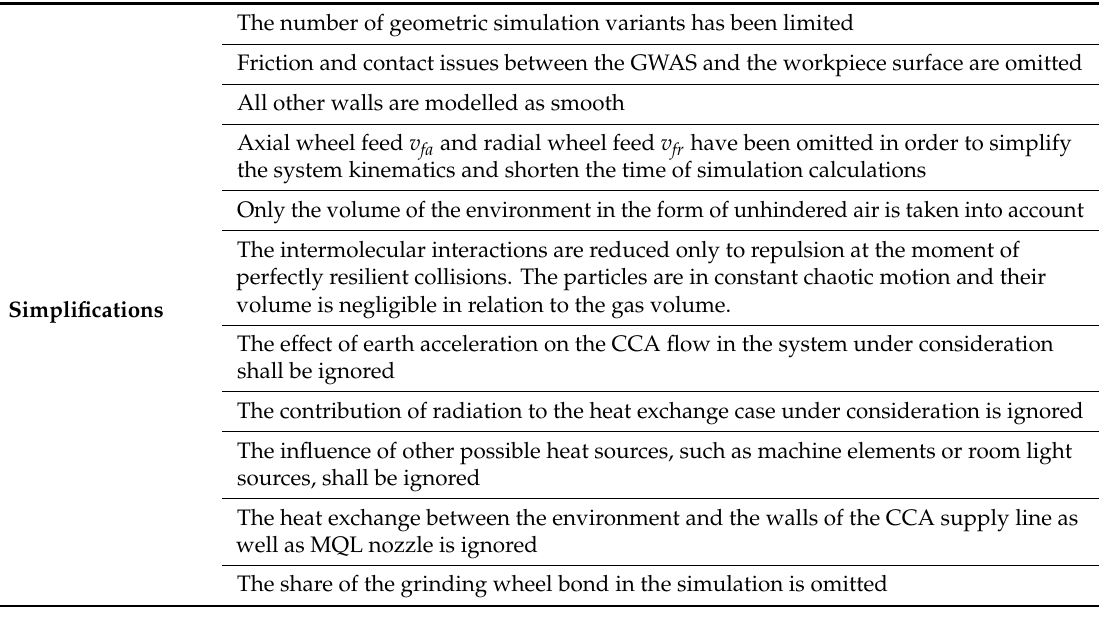
Table 3. Simplifications of simulation.